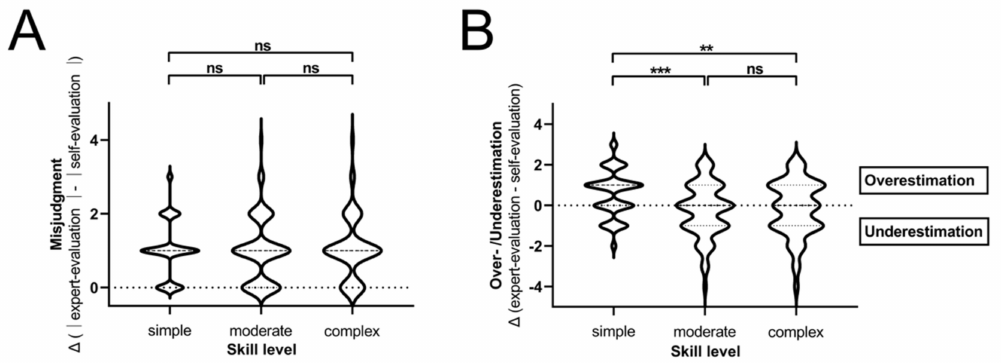
Figure 4. Comparison of global misjudgment and over-/underestimation in online-only cohort. ( A ) Results of misjudgment calculation in the online-only cohort are represented as violin plots subdivided into skill levels. ( B ) Levels of over- and underestimation in different skill levels in the online-only cohort are shown. ** p < 0.005; *** p < 0.0005; ns p > 0.05 (not